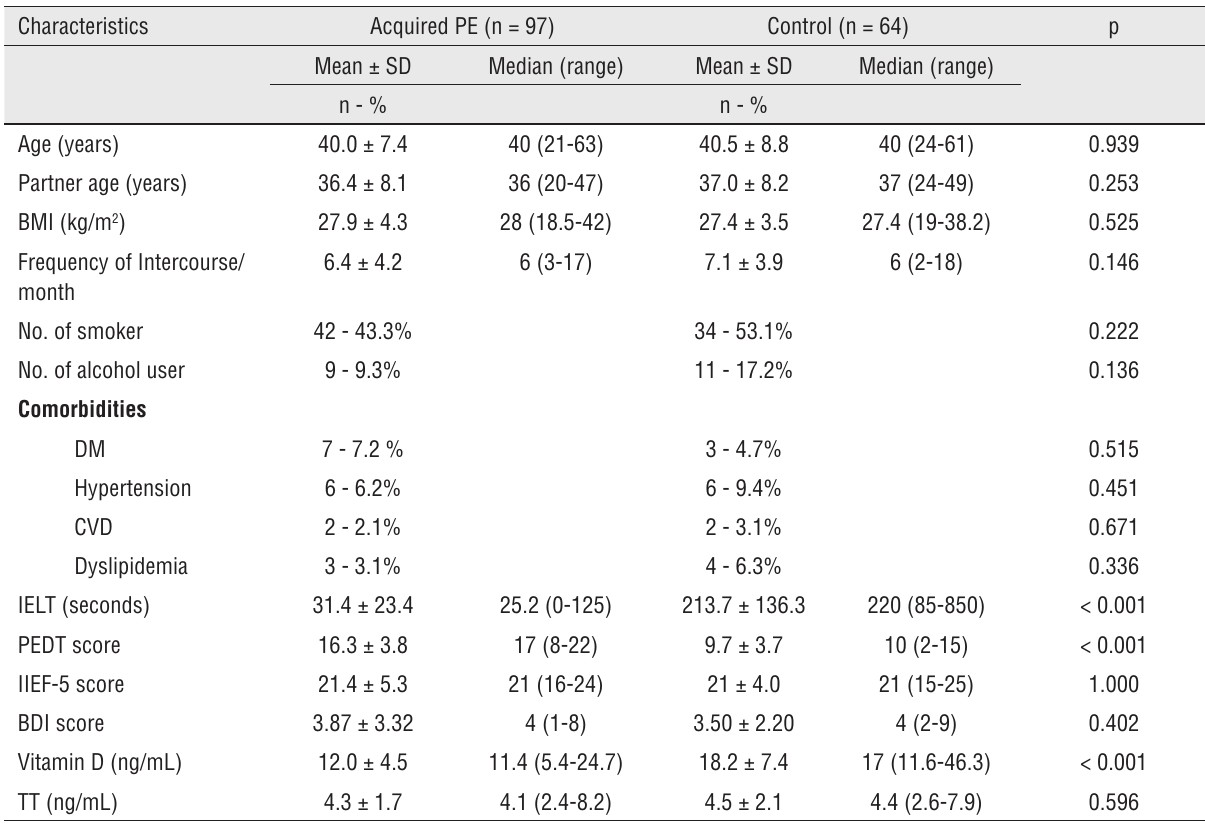
Table 1 - Demographic characteristics of study population. Characteristics